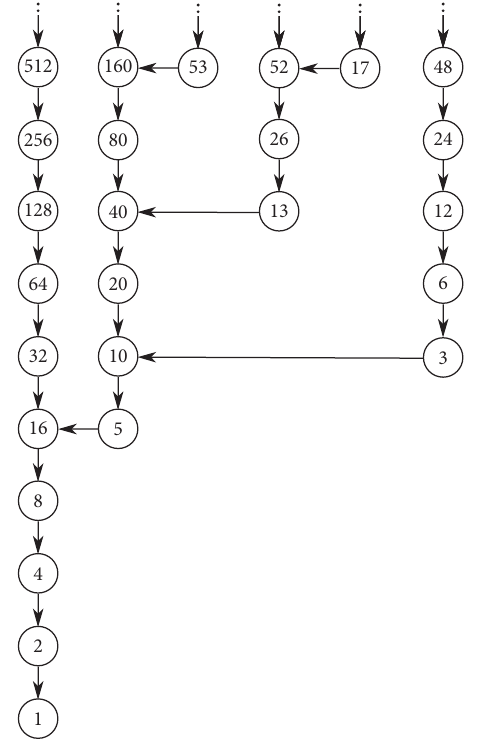
Figure 1: Collatz conjecture